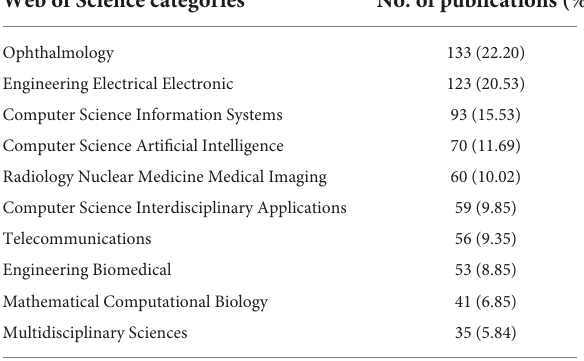
TABLE 2 Top 10 Web of Science categories of journals on artificial intelligence in retina research. Web of Science